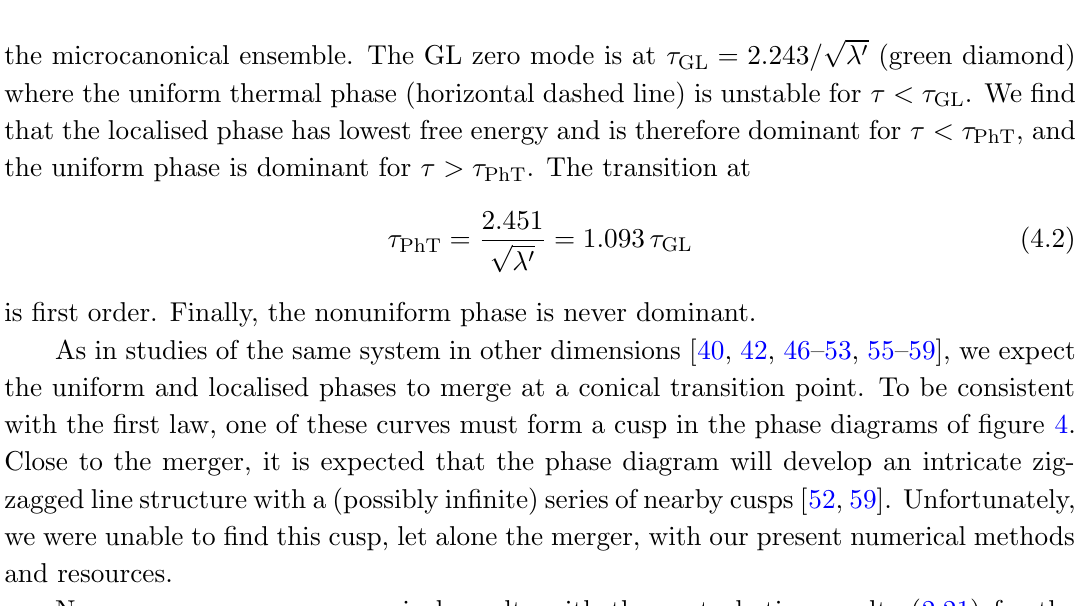
Figure 5 . Convergence of DeTurck norm (left) and entropy (right) for localised black holes at y 0 = 5 = 2. Note the log scale indicating exponential